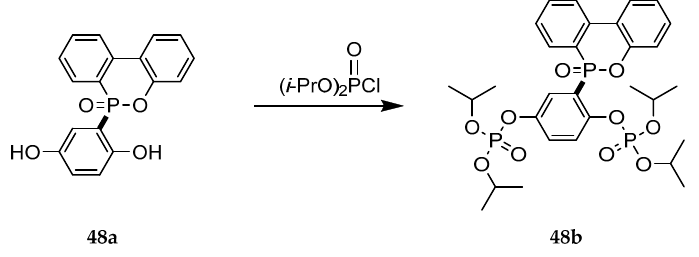
n Figure 23. DOPO-BQ ( 48a ) functionalized DGEBA resin 51 . Similar to the previous study, different epoxy resin 51 were synthesized from reaction of DGEBA and compound 48a in different molar ratios [96] and several dicyanate esters were used as curing agents. TGA data under nitrogen showed evidence that degradation temperature and char yield for the resin increased with the increasing phosphorus content, showing a condensed phase mode of action. UL 94 V-0 rating was attained for formulations containing around 2 wt % phosphorus, when UL 94 V-1 rating was achieved for the resins containing around 1 wt % phosphorus, the curing dicyanate ester having no major influence. Potential applications as flame retardant laminates or protective coatings were suggested for these resins.